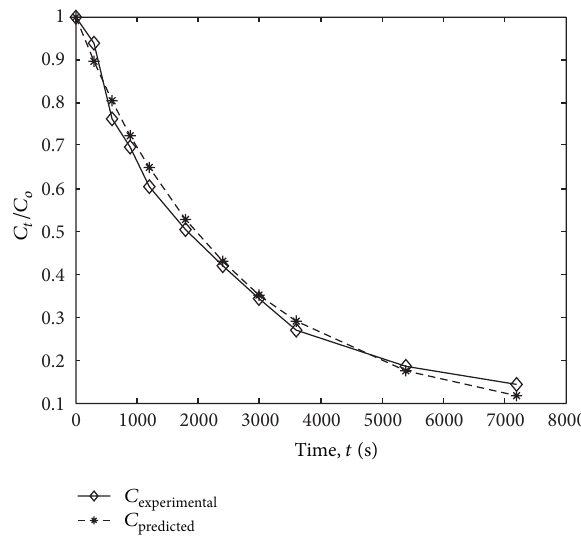
Figure 18: Variation of dimensionless bulk concentration of MB with time for initial bulk concentration of 100